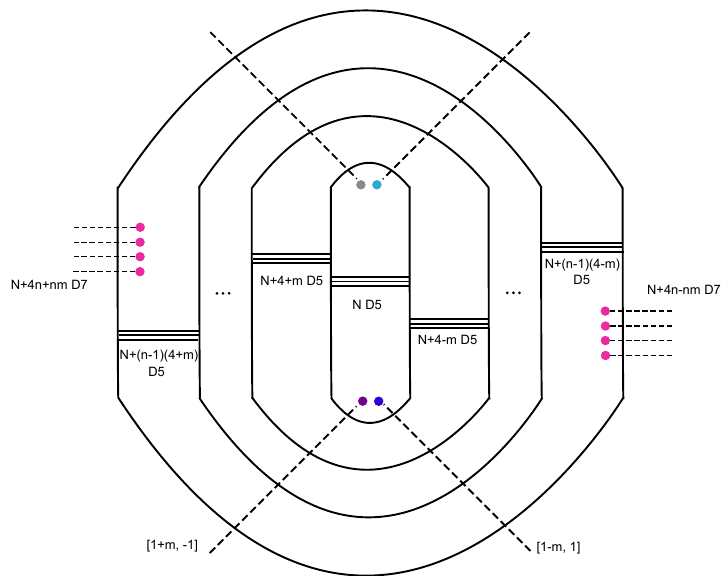
Figure 24 . The 5-brane web diagram after splitting two O 7 that the slope of the lines is schematically depicted and does not represent the corresponding 5-brane charge